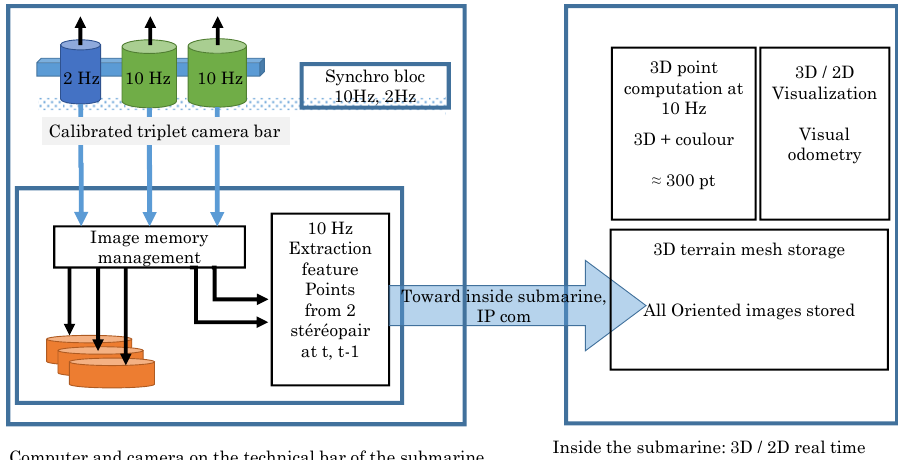
Figure 5. Synoptic description of the photogrammetric approach.